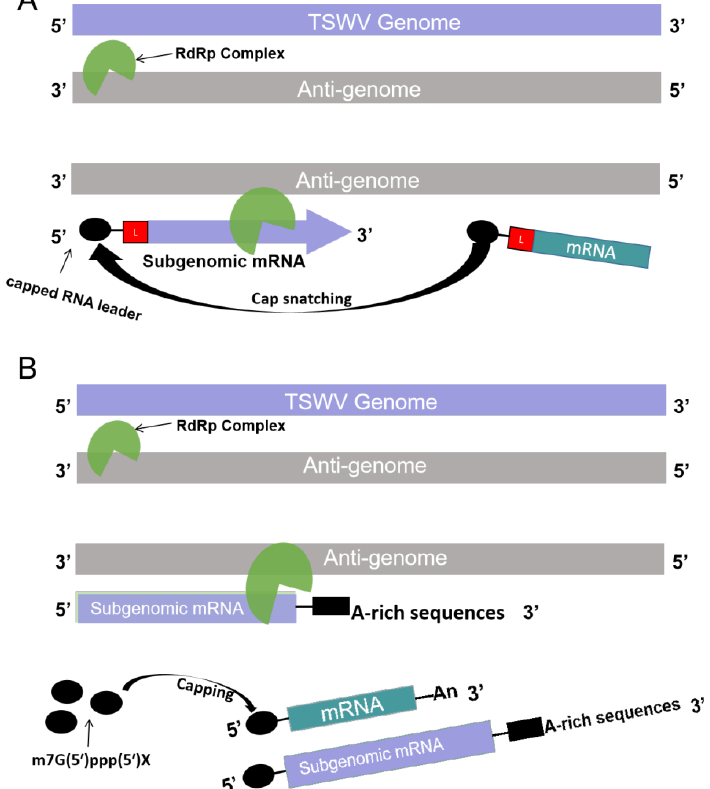
Figure 6. Diagrams of models of TSWV sgRNA generation. ( A ) The viral RNA polymerase cleaves a capped RNA leader from host cellular mRNAs and use these as primers for transcription on the viral genome for sgRNA generation. ( B ) mRNAs and sgRNA are capped by capping enzyme.